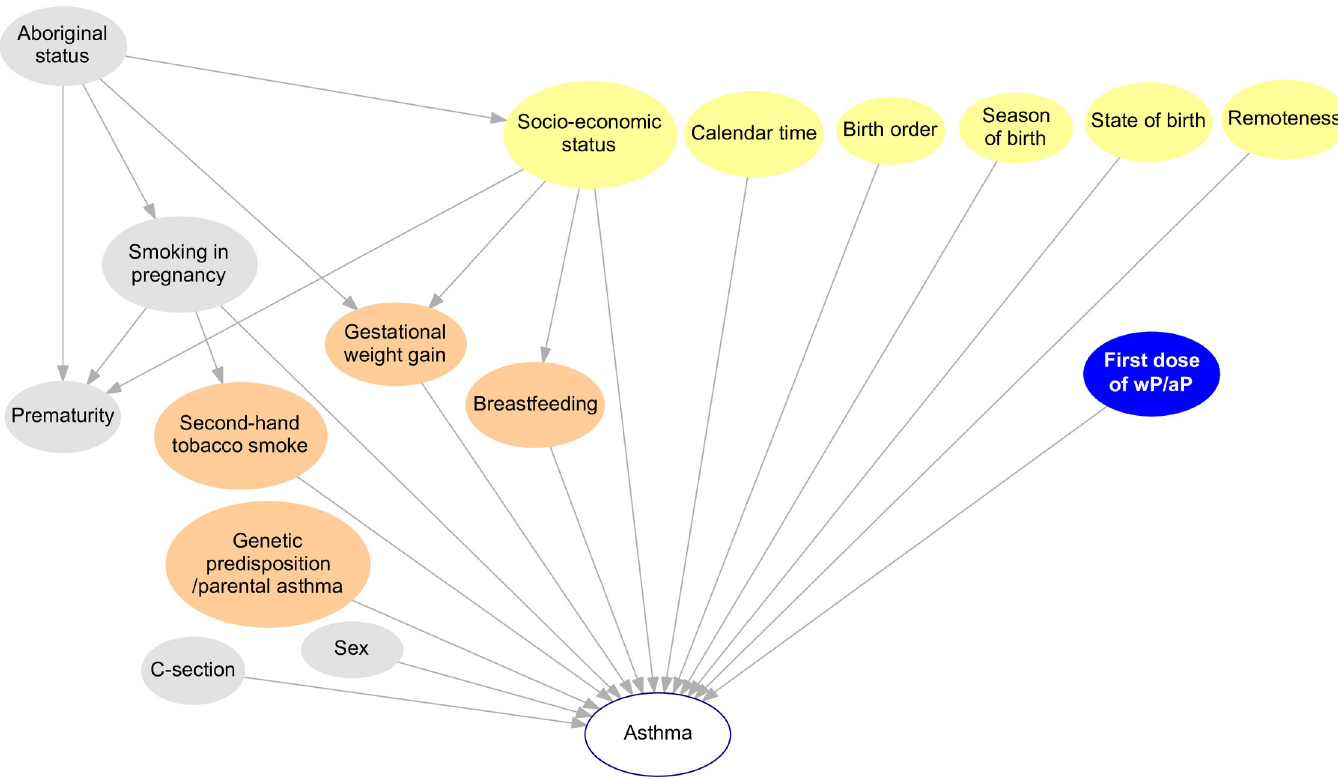
Fig 4. Direct acyclic graph after adjustment by confounders and baseline covariates. The blue node represents the exposure (wP or aP); orange and grey nodes: Perinatal, environmental and biological factors at birth/before the exposure that may influence the outcome of interest, but not the receipt of the study vaccines; brown nodes: Confounders of the association between the exposure and atopic asthma; yellow nodes: Adjusted variables; white node: Outcome of interest. Because the association between low birthweight and asthma is mainly driven by gestational age at delivery, birthweight is not depicted in this diagram [40]. C-section: Birth by caesarean. Data are available for all the nodes except for those in